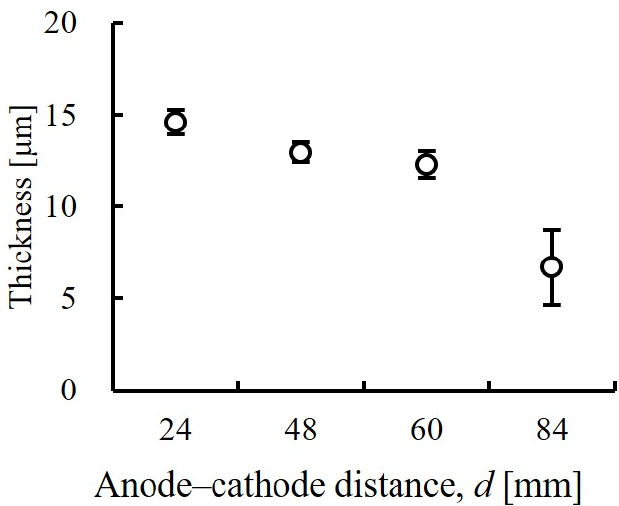
Figure 3. Evaluation of variations in Ni-coating thickness. The inter-electrode distance during Ni electroforming was set to four values, and the film thickness was measured by performing pro- cessing for 10 min at a target film thickness of 10 µm. The average film thickness of 12.9 µm and σ = 0.49 µm minimized the variation at an interelectrode distance of 48 mm. As the coating thickness is proportional to the electroforming time, if the variation is small, the desired film thickness can be obtained via time adjustment. Figure 4. Substrate in-plane-coating thickness distribution. The average film thickness is 12.3 µm and σ = 0.72 µm, with a 60 mm inter-electrode distance, and at 48 mm, the variation is minimized, with an average film thickness of 12.9 µm and σ = 0.49 µm. There is almost no difference in the substrate in-plane film thickness with a 48 mm inter-electrode distance, and the variation is the smallest in this case. 3.2. Evaluation of Stiffness of Metal Structures Figure 5 shows the hardness measurement results for the four types of samples, to evaluate the stiffness of the Ni structure. Sample (a) is a Ni coating obtained from the basic bath in Table 1, (b) is a coating adjusted with a high-hardness additive, (c) is a Ni–P alloy coating, and (d) is a sample of Ni–P coating heat-treated at 350 °C for 1 h. Compared to the Ni films in samples (a) and (b), the Ni–P alloy films in samples (c) and (d) are harder, especially in the sample (d), which was heat-treated and had a high Vickers hardness of 950 HV. This high hardness is thought to be due to crystallization [37,38] of the Ni–P alloy